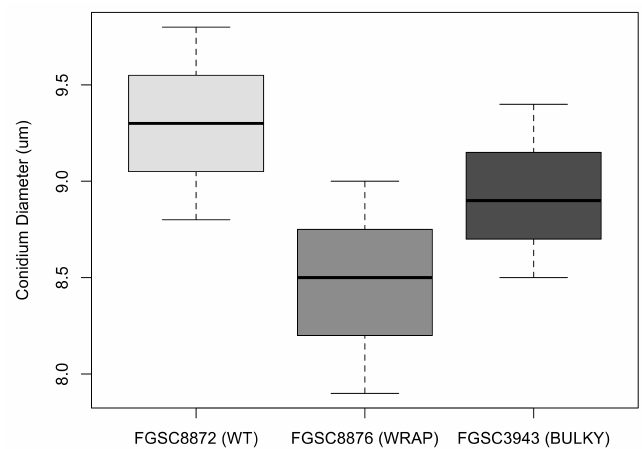
Figure 8. Average conidium diameter in microns when suspended in water for each architectural phenotype. The dataset includes three biological replicates. The box shows the 25th and 75th percentiles, with the median denoted as a line inside. The whiskers represent the range of data. The t -test results for pairs are as follows: WT–Wrap, p = 0.125; Wrap–Bulky, p = 0.3219; WT–Bulky, p = 0.3995.